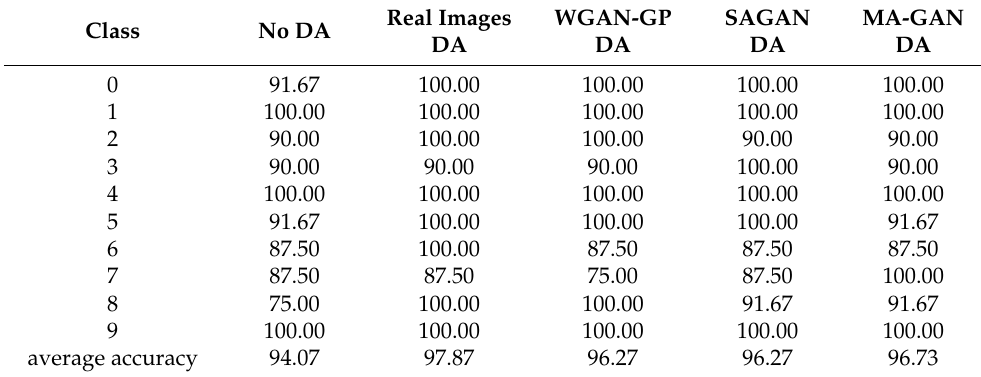
Table 11. Classified accuracy of MNIST training set after augmentation by different methods (%).